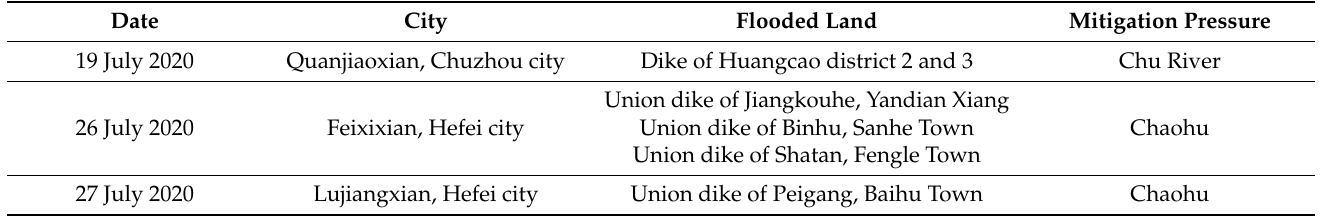
Table A3. Flooding area distribution caused by active dam